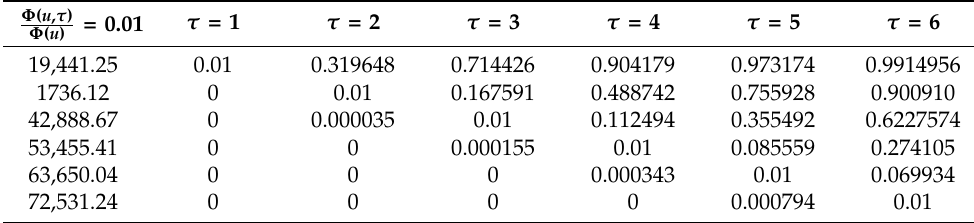
Table 10. Optimal reinsurance parameters q = 0.7939, α / S = 0.7646 and an ensured surplus of 45,000. Φ ( u , τ ) Φ ( u ) =